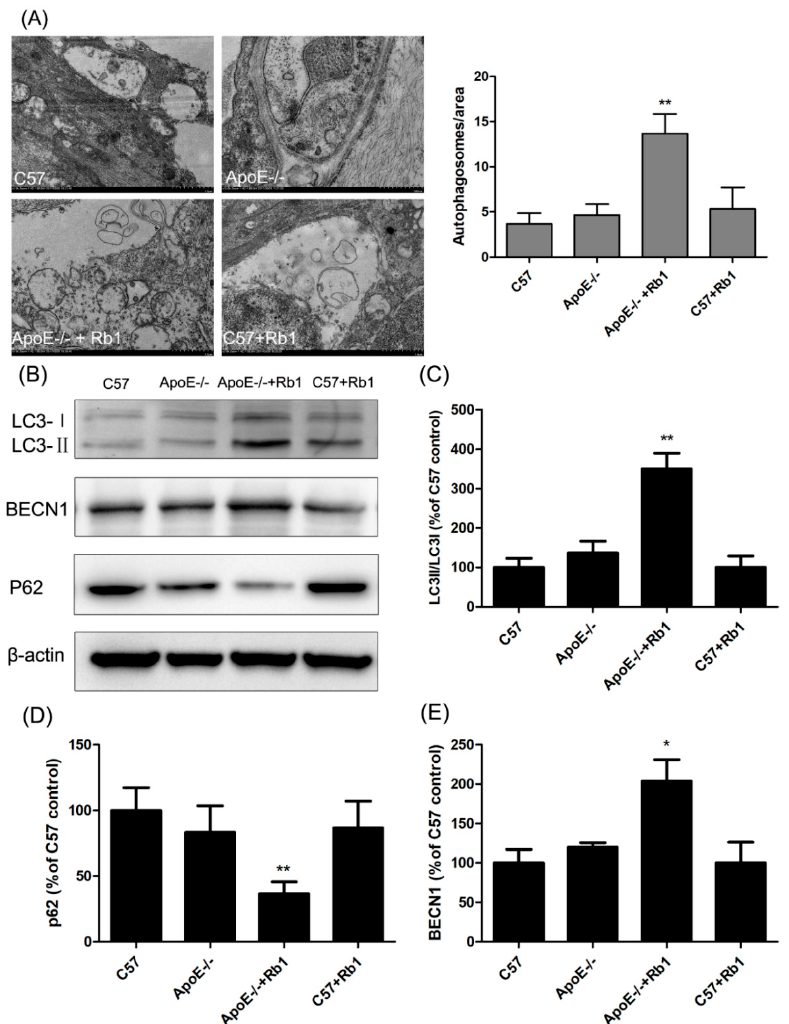
Figure 7. Rb1 administration accelerated autophagy in the aorta of ApoE-/- mice. ( A ) Ultrastructure of endothelial cells of the aorta in each group as revealed by transmission electron microscopy. ( B ) The membrane type of LC3 as well as BECN1 and p62 expression were detected by western blot analysis. ( C ) Quantitative analysis of the LC3-II/LC3-I ratio, ( D ) p62 and ( E ) BECN1. The data are expressed as the mean ± the standard error (SE) of the mean in each group ( n = 3). * p < 0.05, ** p < 0.01 vs. ApoE-/-